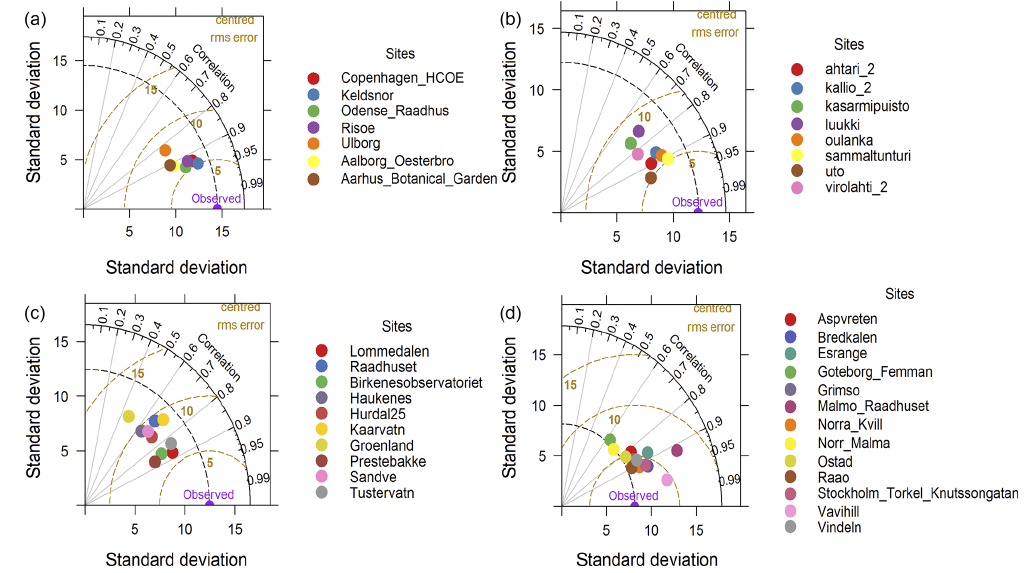
Figure 2. Taylor diagrams for daily mean O 3 for all stations in (a) Denmark, (b) Finland, (c) Norway and (d) Sweden.